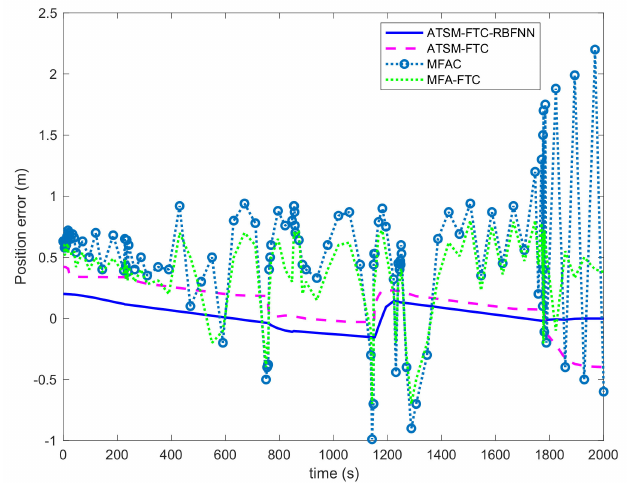
Figure 14. Position error comparison.